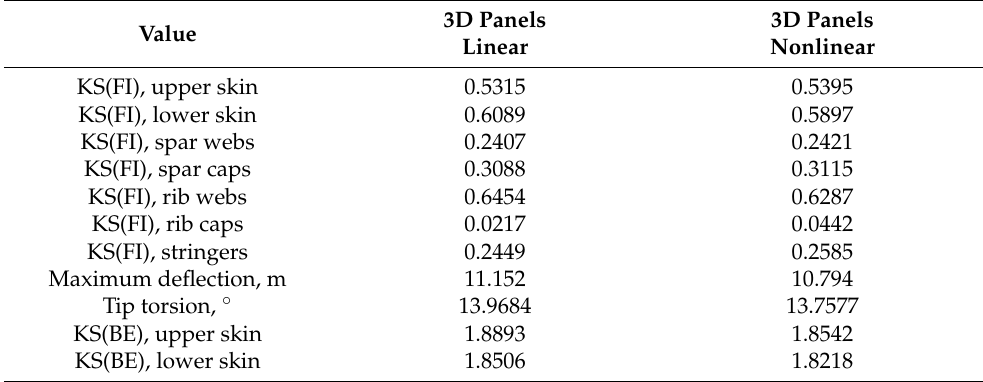
Table 10. Linear and nonlinear structural response comparison